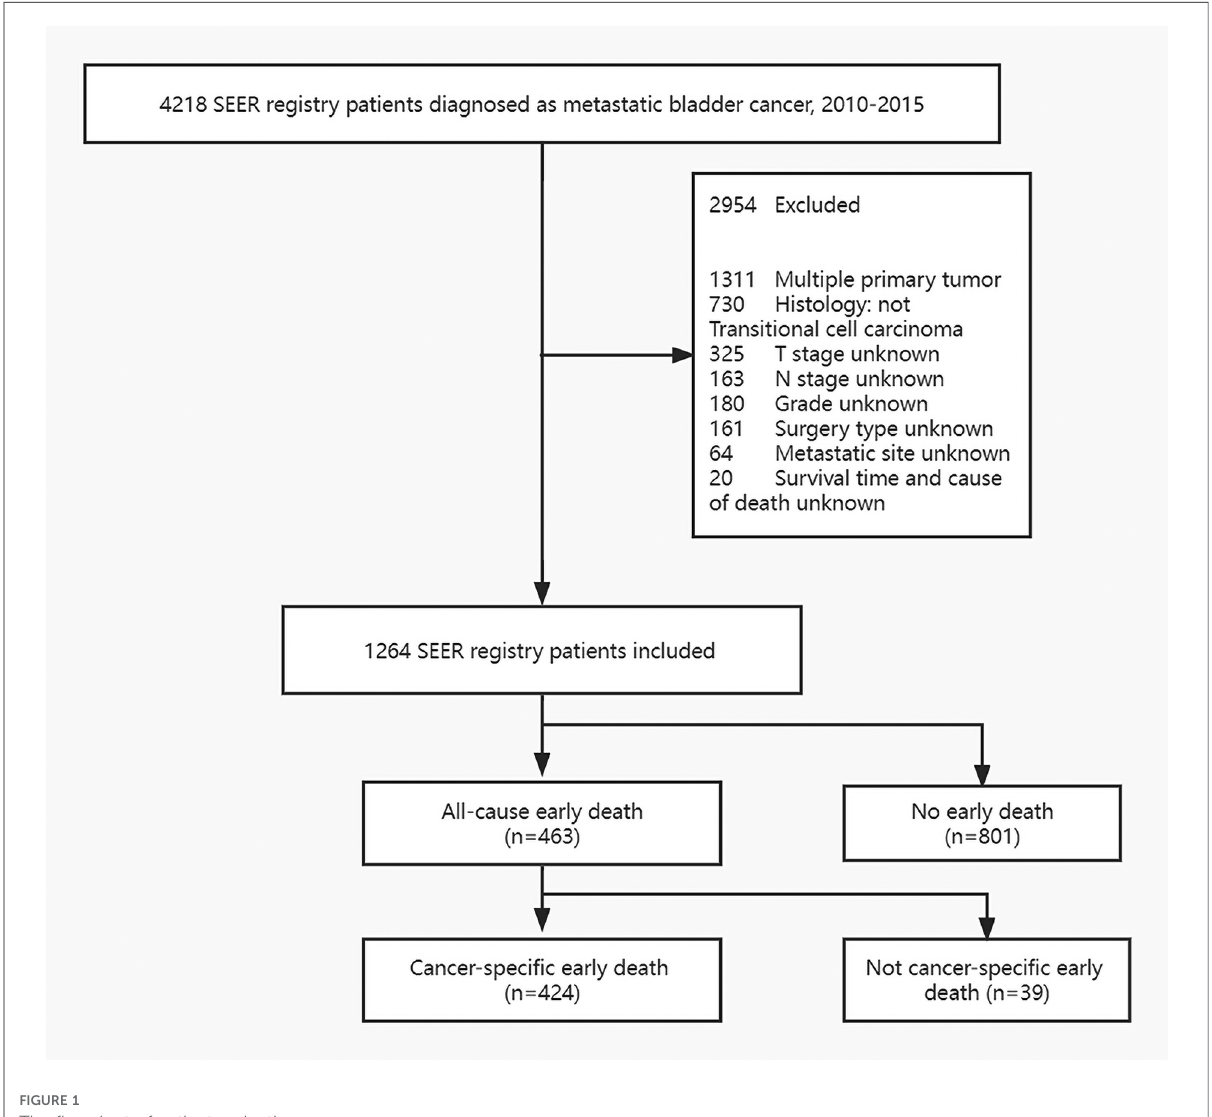
FIGURE 1 The fl owchart of patients